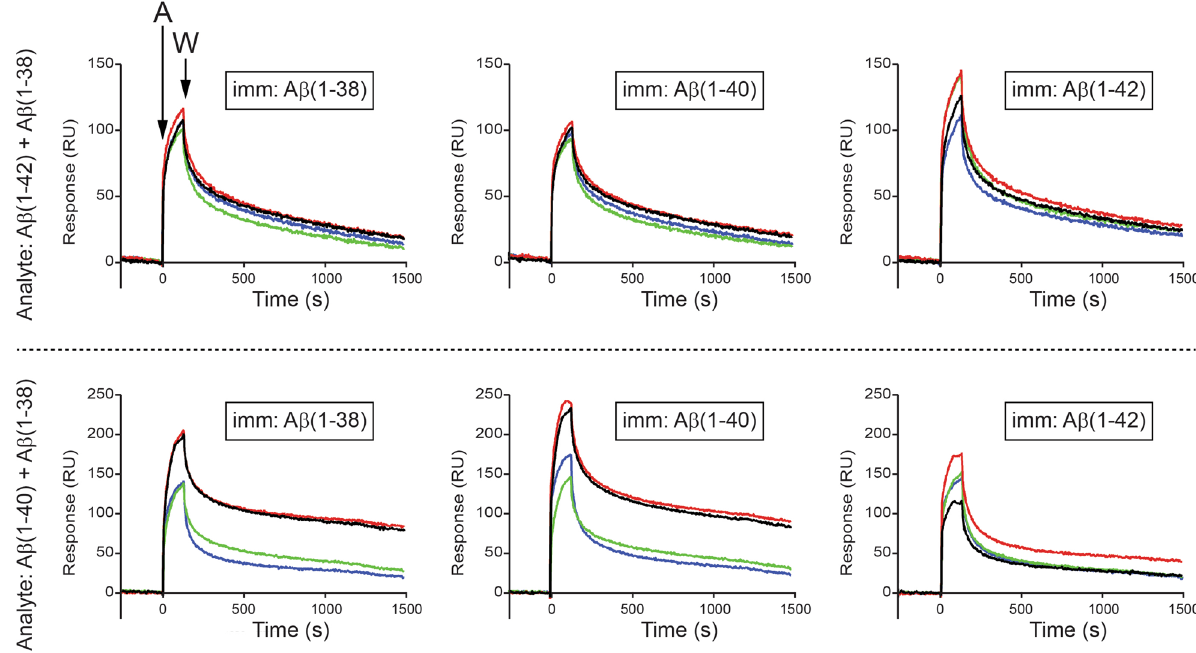
Figure 11. Surface plasmon resonance reveals complex interactions between Aβ(1–42), Aβ(1–40), and Aβ(1– 38). Freshly prepared Aβ(1–38), Aβ(1–40), or Aβ(1–42) peptides were immobilized (imm.) on to biosensor chips. Test (analyte: ‘A’) solutions injected (5 µL/min for 120 s) over the surfaces contained 1200 nM of either ( left panels ) Aβ(1–42) or ( right panels ) Aβ(1–40) either alone (black sensorgrams) or also containing 50 nM Aβ(1–38) (red sensorgrams); 100 nM Aβ(1–38) (green sensorgrams); or 200 nM Aβ(1–38) (blue sensorgrams). The dissociation phase of the binding was monitored by replacing the analyte solution with wash buffer (‘W’). Sensorgrams are representative of three or more experimental